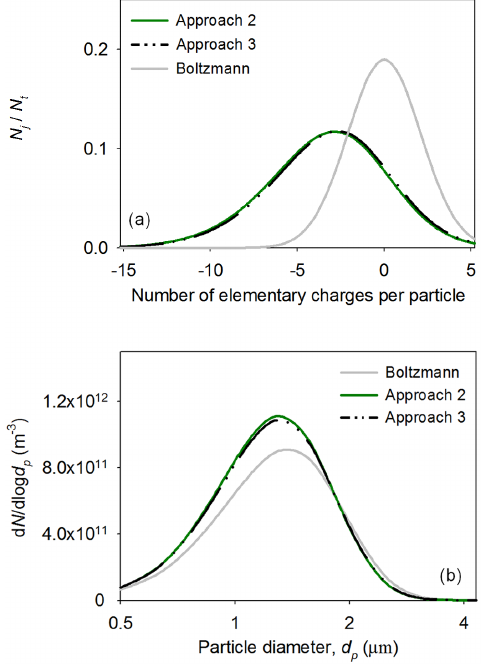
Figure 13. The charge (a) and size (b) distributions of initially monodispersed 134 Cs particles ( d p = 0 . 5µm, A Cs-134 = 14 . 5Bq; N t = 10 13 m − 3 ) . The simulation time is